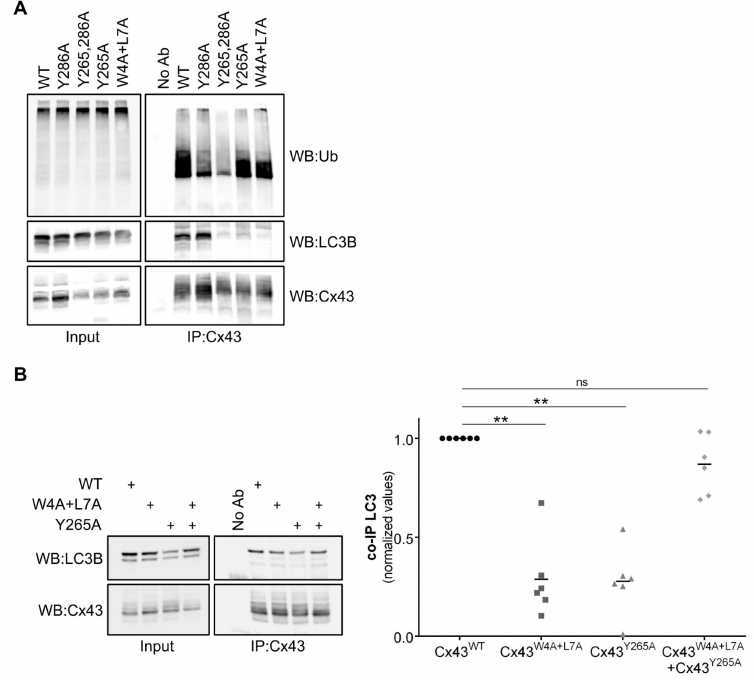
Figure 4. Tyrosine 265 of Cx43 is important for the interaction with LC3B. ( A ) HEK293A cells were co-transfected with GFP-LC3B and either wild type (WT) or mutant Cx43 (Y286A, Y265,286A, Y265A, W4A + L7A). Cell lysates were then subjected to immunoprecipitation with goat polyclonal antibodies against Cx43, and the precipitates were analysed using Western blot using mouse monoclonal antibodies against ubiquitin, or rabbit polyclonal antibodies against Cx43 and LC3B. ( B ) HEK293A cells co-transfected with GFP-LC3B and several combinations of wild type (WT) or mutant Cx43 (Y265A, W4A + L7A). Cell lysates were then subjected to immunoprecipitation with goat polyclonal antibodies against Cx43, and the precipitates were analysed using Western blot using rabbit polyclonal antibodies against Cx43 and LC3B. The level of co-immunoprecipitated LC3B with each connexin was quantified, normalized to the immunoprecipitated connexin and plotted in a graph. ** p < 0.01, ns: non-significant using a Kruskal-Wallis test, followed by Dunn’s multiple comparison